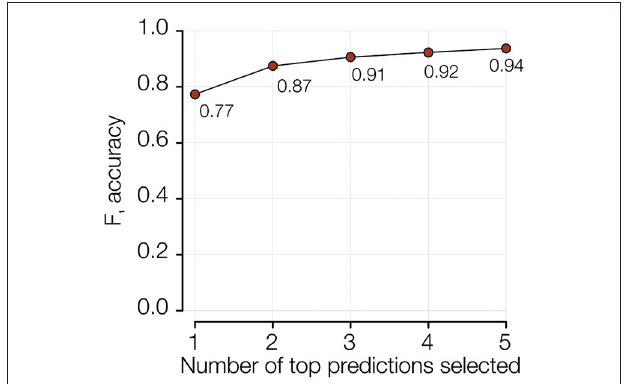
FIGURE 5 | Probability of predicting the correct PFGE pattern within top 5